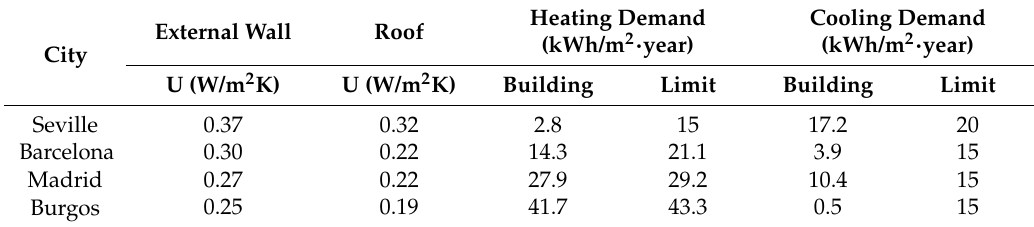
Table 2. U-values for external walls and roof, and heating and cooling demands.